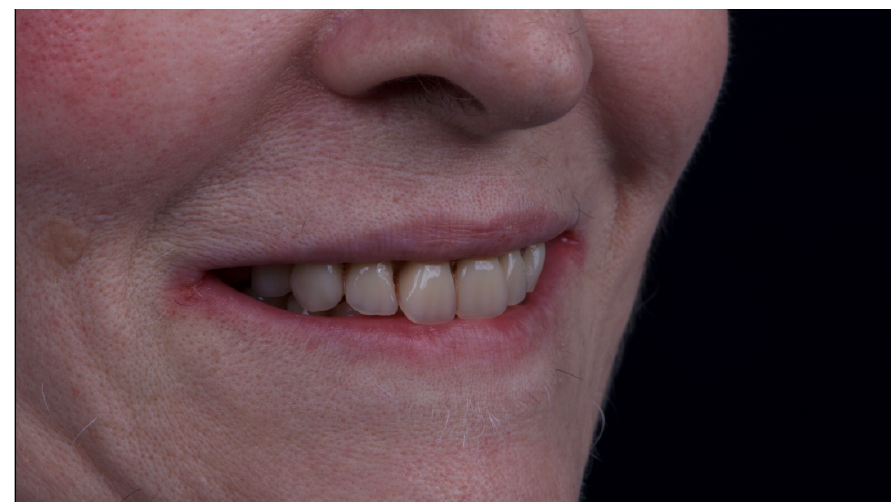
Figure 15. Smile test accepted by the patient.